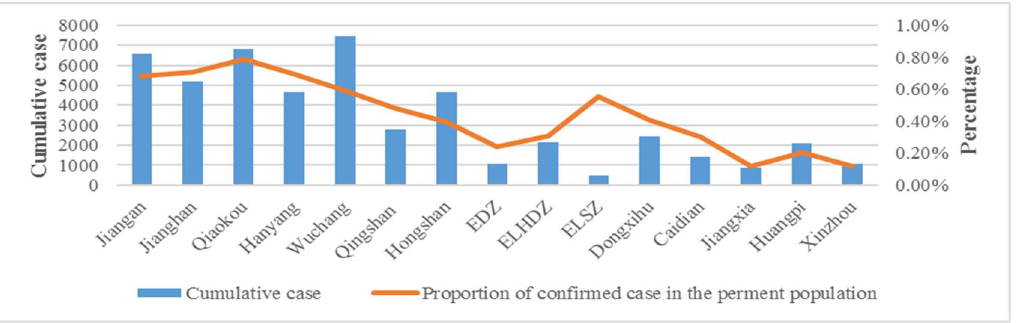
Figure 5. The amount of cumulatively confirmed cases of COVID-19 in Wuhan (by 8 April 2020).